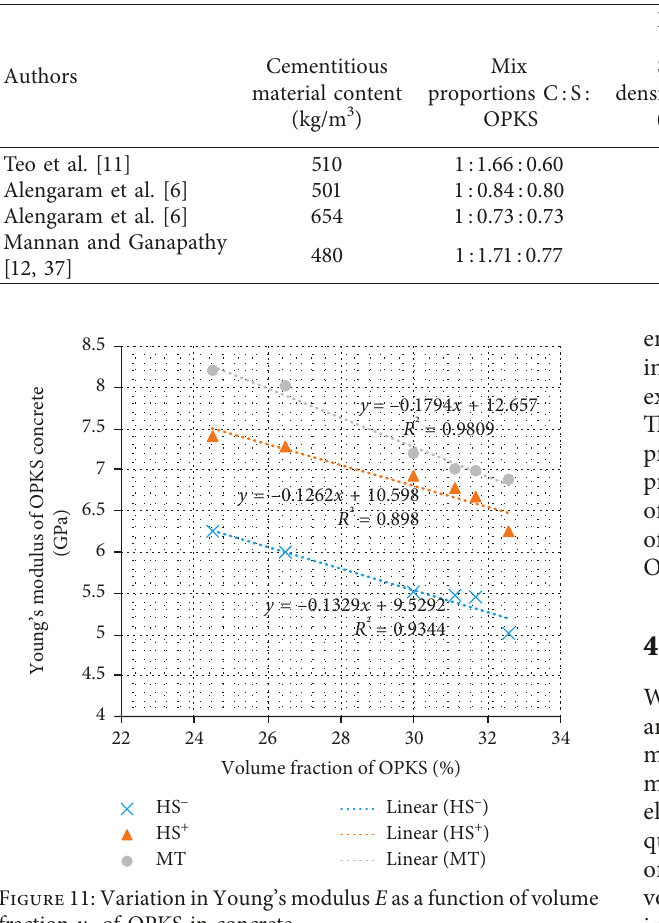
Table 9: Experimental values for the physical and mechanical properties of OPKSC reported in the literature that are used for a comparison with the E -values estimated using homogenisation techniques.